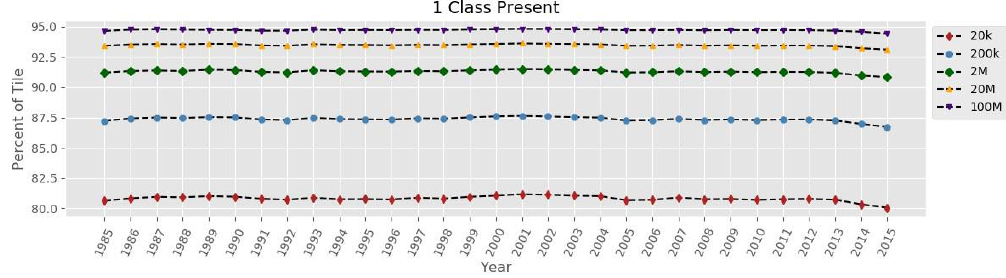
Figure 5. The proportion of tile H03V09 that has consistent results through eight iterations of classification for a total of 20K, 200K, 2M, 20M, and 100M stratified National Land Cover Database (NLCD) 2001 samples.